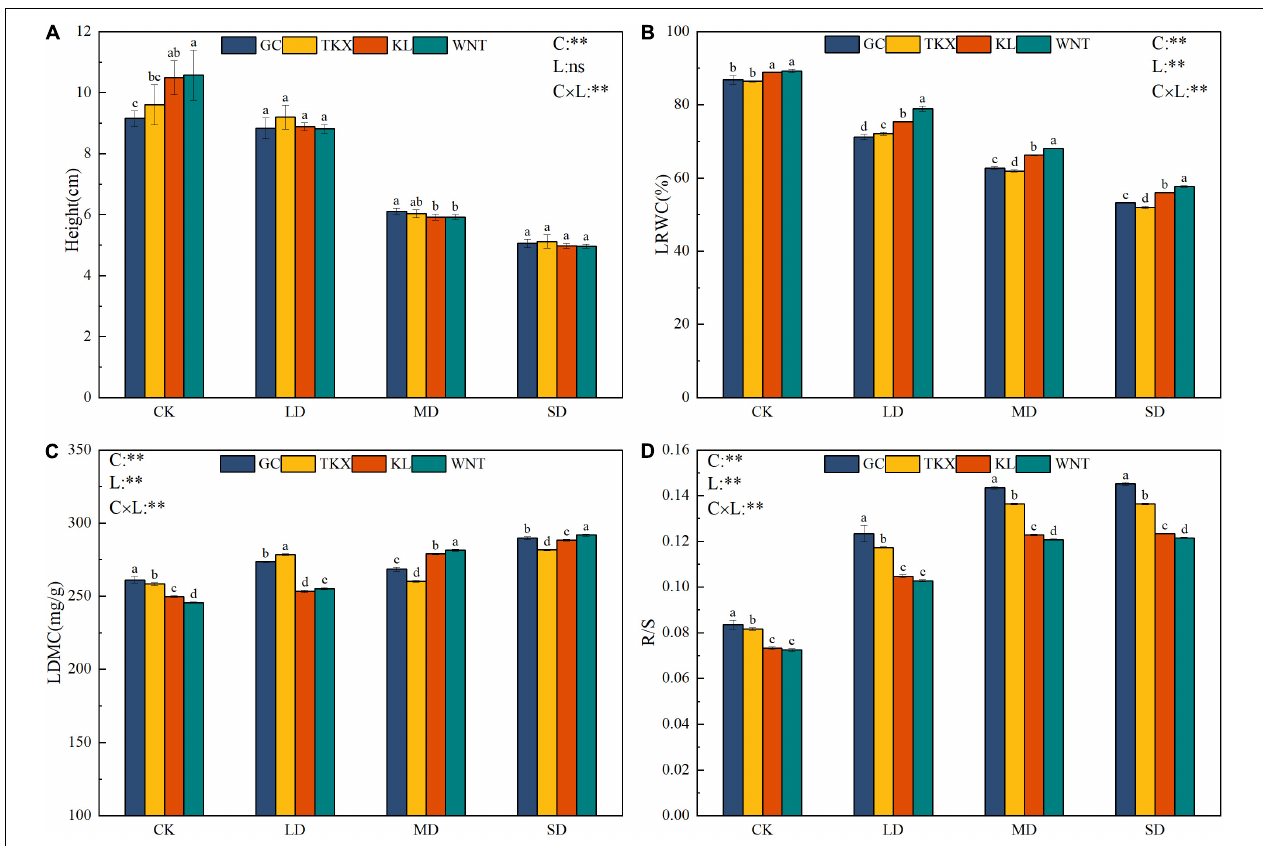
FIGURE 2 | Change in functional traits of different geographical populations of Solanum rostratum under drought stress. Plant height [Height (cm)] (A) , leaf relative water content [LRWC (%)] (B) , leaf dry matter content [LDMC (mg/g)] (C) , and root shoot ratio [R/S (%)] (D) of treatments with the indicated polyethylene glycol concentrations. The blue column represents the GC site, yellow column represents the TKX site, red column represents to KL site, and green column represents the WNT site. Different lowercase letters indicate a significant difference under drought stress in S. rostratum populations, according to Duncan’s test ( α = 0.05). C refers to the differences among drought-stress concentrations; L refers to the differences among each geographical population; C × L refers to the interaction between populations and concentration. The significant change in functional traits between the four collection sites was shown by the significance of population–stress treatment interactions. Asterisks indicate a significant difference (*, p ≤ 0.05; **, p ≤ 0.01; ***, p ≤ 0.001). Refer to statistics in Supplementary Table 1